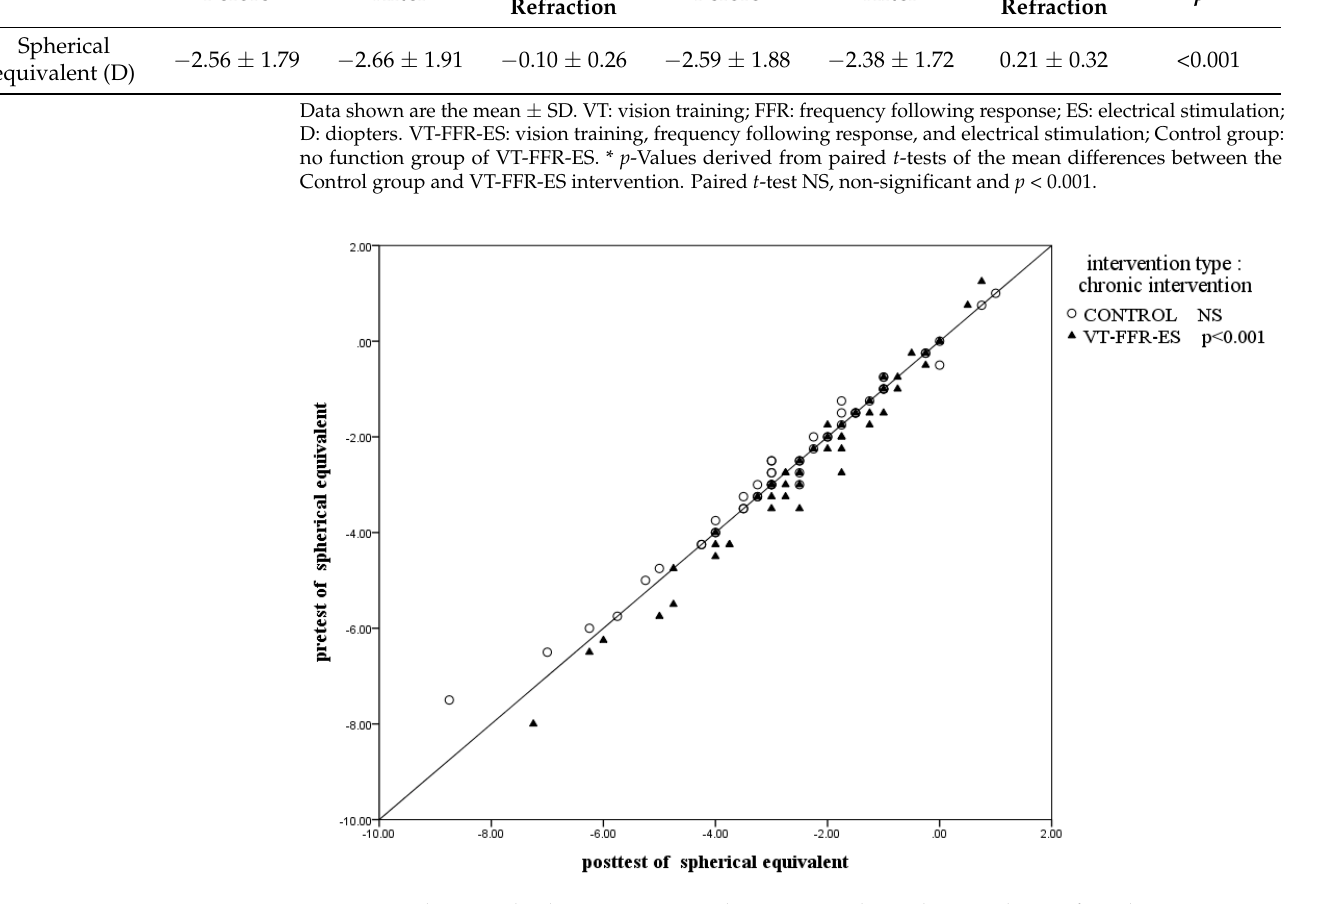
Figure 4. Identity plot between pre- and post-test spherical equivalents after chronic VT-FFR-ES intervention.